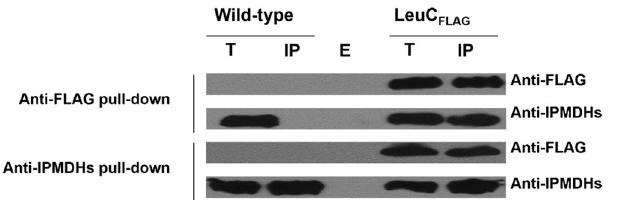
Figure 2. Physical interaction between LeuC and IPMDH in vivo. Chloroplastic proteins prepared from wild-type and LeuC - FLAG transgenic plants were incubated with anti-FLAG antibody-coupled agarose or anti-IPMDH antibody-coupled agarose. The immunoprecipitate (IP) and the total protein (T)were separated on SDS-gels and subjected to Western blot analysis with anti-FLAG and anti-IPMDH antibody, respectively. E, IP control using empty